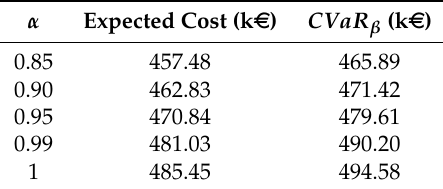
Figure 4. Optimal procurement plan. Table 2. Cost increase as function α